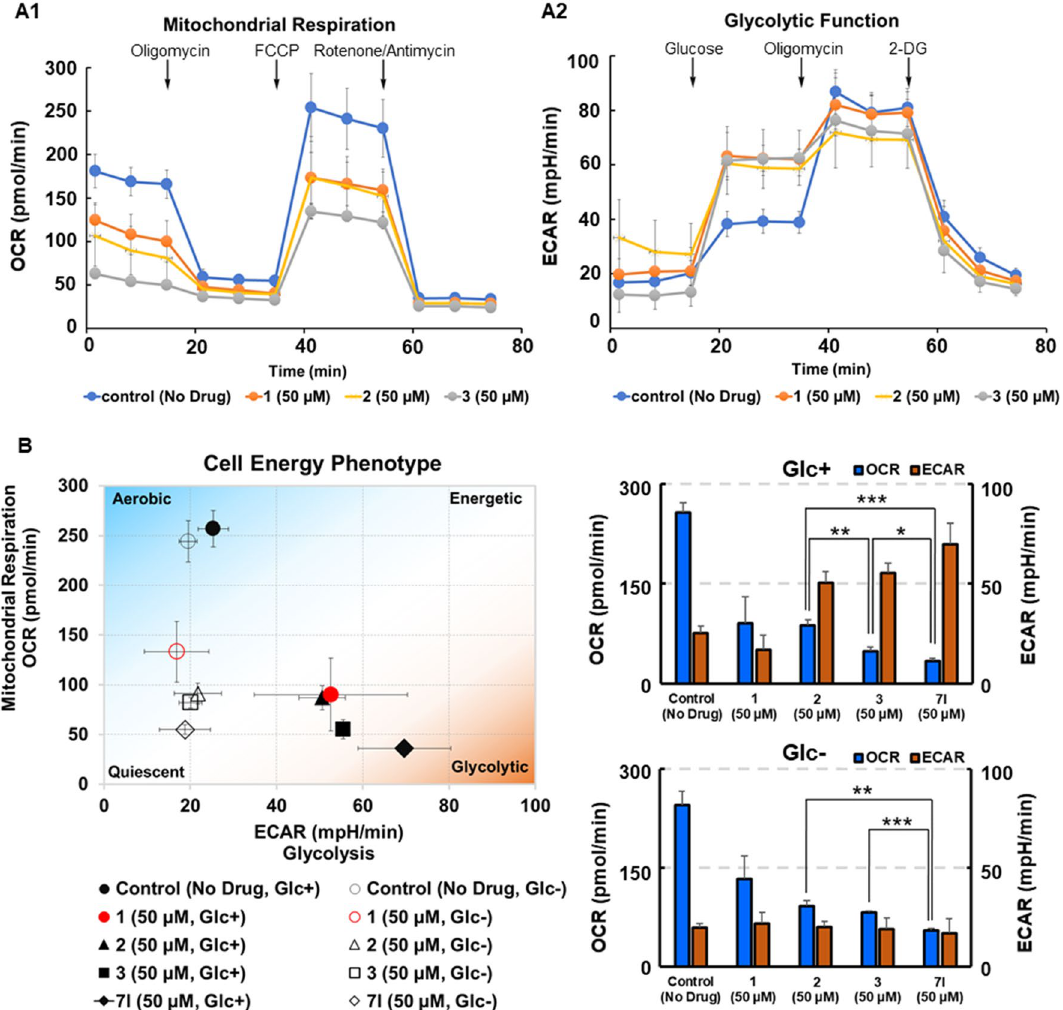
Figure 5. Influence of biguanides on the energy metabolism of HT29 in the presence or absence of glucose. ( A1 ) HT29 cells were treated with 50 μM of 1, 2 , and 3 in assay medium (glucose, 10 mM) for 1 h, and then the OCR was measured over time using an XFp extracellular flux analyzer while sequentially injecting oligomycin (1.5 µM), FCCP (2 µM) and rotenone/antimycin A (0.5 µM each). ( A2 ) HT29 cells were treated with 50 μM of 1 , 2 , and 3 in glucose-free assay medium for 1 h, and then the ECAR was measured over time while sequentially injecting glucose (10 mM), Oligomycin (1 μM) and 2-DG (50 mM). ( B ) Cell energy phenotype profile of HT29 cells treated with biguanides. After the treatment with 50 μM of 2 , 3 , and 7l in glucose-containing (Glc +) or non-glucose (Glc −) assay medium for 1 h, OCR and ECAR were measured by XFp extracellular flux analyzer. The differences in OCR values between each compound treatment were statistically significant (* p < 0.05; ** p < 0.005; *** p < 0.0005). Each data represents mean ± SD of triplicate 3 at concentrations of 50 μM, while ECARs derived from the glycolysis increased to compensate for OXPHOS. The o -chloroaryl derivatives 3 and 7l significantly suppressed OCR and enhanced ECAR in HT-29 cells relative to 1 and 2 at concentrations of 50 μM in the presence of glucose (Fig. 5B). On the other hand, both OCR and ECAR were suppressed in the glucose-free medium. In particular, 7l reduced the OCR completely (33.4 pmol/ min) until the level of non-mitochondrial oxygen consumption in the presence of glucose. Correlations between ECAR and OCR of cells treated with various biguanides in both normal and glucose deprived conditions are shown in the energy phenotype profile diagram (Figs. 5B and S6). The responses of various tumor cell lines to energy demands under each culture condition reflects their metabolic potential. U87MG gliomas exhibited a Warburg phenotype of low OCR and high ECAR compared to other cells under normal conditions 40 , and the metabolisms of all cell lines were reprogrammed toward a more oxidative phenotype under conditions of glucose deprivation 41 . The energy phenotype profile diagram shows that the presence of biguanides led to a sig- nificant reduction in OCR both in the presence and absence of glucose in all cell lines; the order of the strength of inhibition was 7l > 3 > 2 > 1 . In total, of the compounds examined, 7l inhibited OXPHOS most potently, such that the inhibitory effect was observed even at a concentration of 25 μM. In the presence of glucose, stronger OXPHOS inhibitor caused greater increases in ECAR. In addition, when energy production by mitochondrial